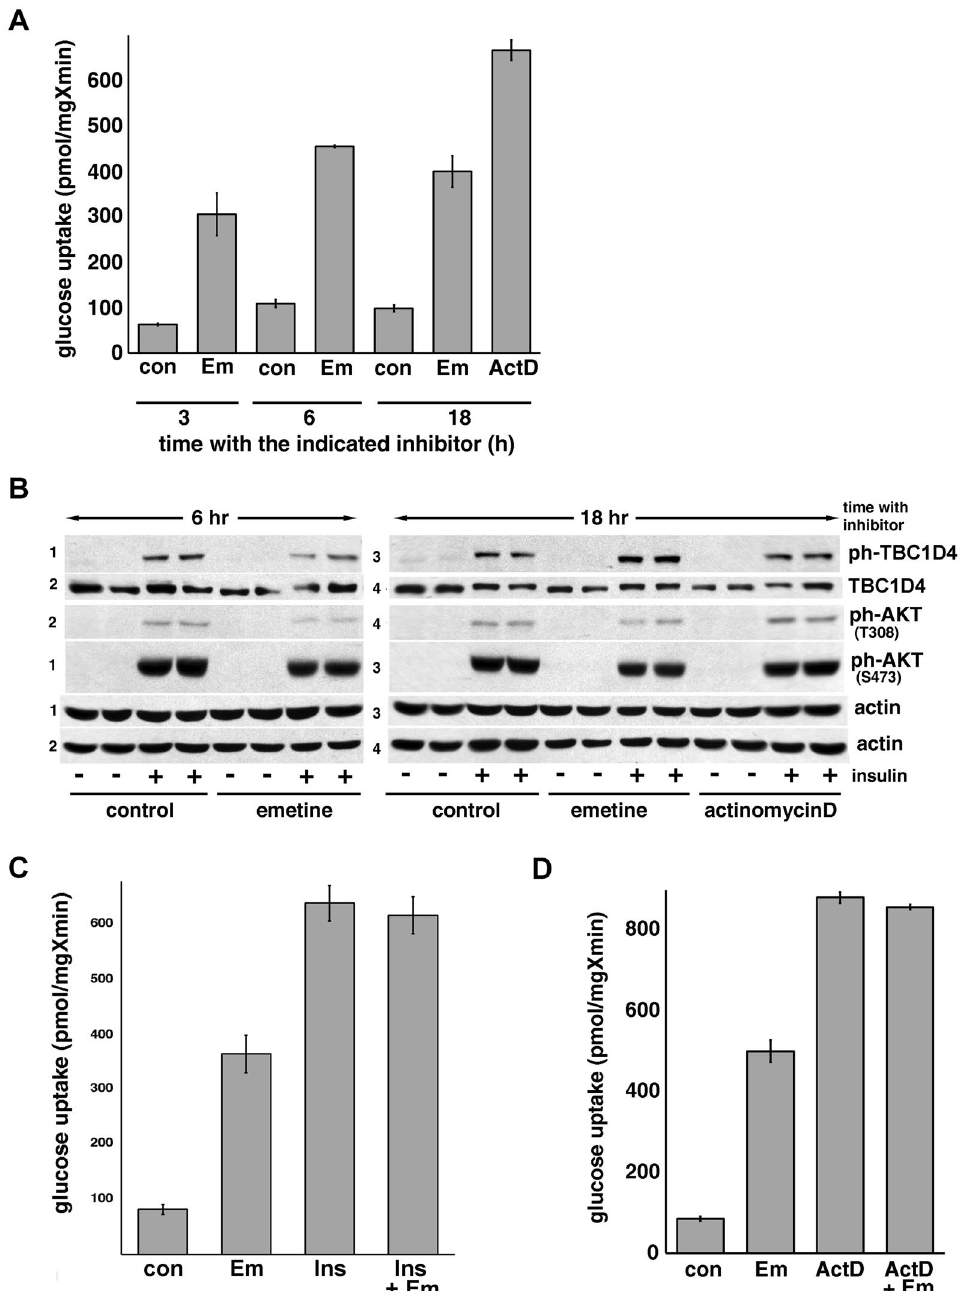
Figure 5. Emetine increases glucose uptake without engaging the insulin signaling pathway. Panel ( A ): differentiated 3T3-L1 adipocytes were incubated without (con) or with emetine (Em, 20 µM) and ActD (5 µM) for the indicated amount of time and assayed for glucose uptake. The error bars represent standard deviations. Panel ( B ): adipocytes were treated with emetine and ActD similar to samples in Panel ( A ), and the lysates from duplicate wells were analyzed by Western blotting. The panel represents a combined image of four different gels as indicated on the left. Loading controls (actin) shows equal loading and exposures. Panel ( C ): differentiated 3T3-L1 adipocytes were incubated without (con) or with emetine (Em, 20 µM, 6 h) and subjected to the glucose uptake assay in the absence and in the presence of insulin (100 nM, 15 min). The error bars represent standard deviations. Panel ( D ): Differentiated 3T3-L1 adipocytes were incubated in the absence (con) and in the presence of emetine (Em, 20 µM, 6 h), ActD (5 µM, 18 h), and combination of the drugs (5 µM ActD for 18 h and 20 µM of emetine for the last 6 h) as indicated and assayed for glucose uptake. The error bars represent standard